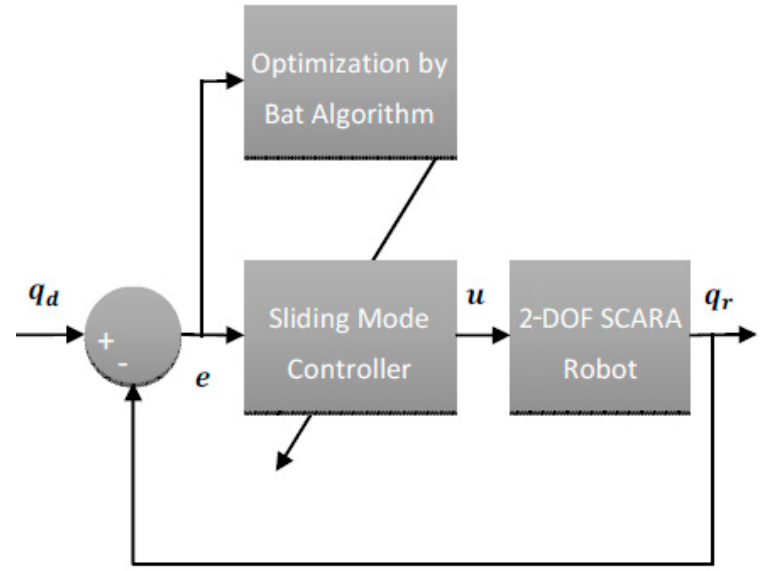
Figure 3. Sliding mode controller with the Bat algorithm for a two-DOF SCARA robot.